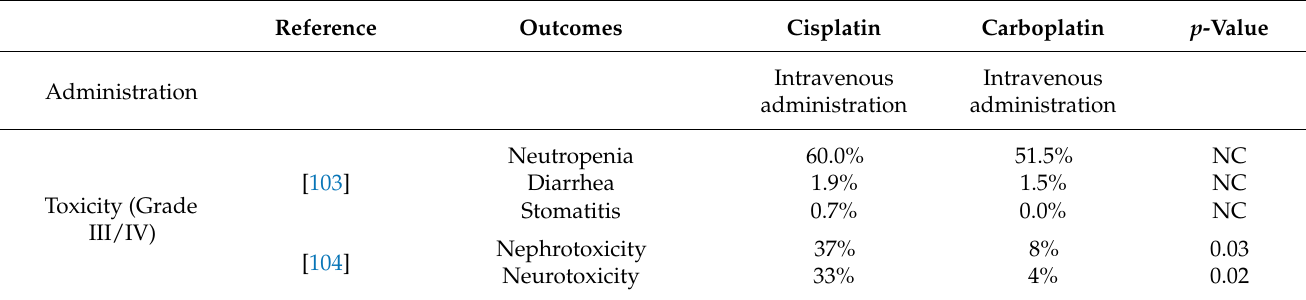
Table 3. Comparison of cisplatin- and carboplatin-based chemotherapeutic treatments.